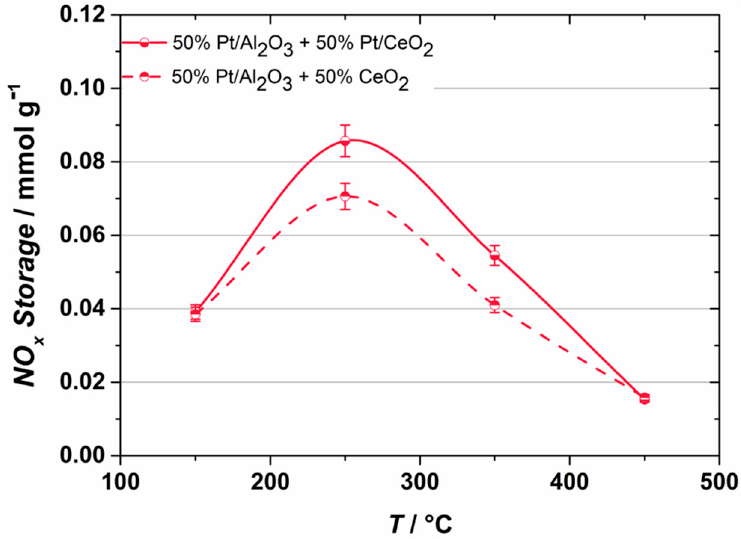
Figure 2. Temperature dependent NO X storage capacity from non-activated ceria (black line) and platinized CeO 2 (dashed line) in a physical mixture with Pt/Al 2 O 3.